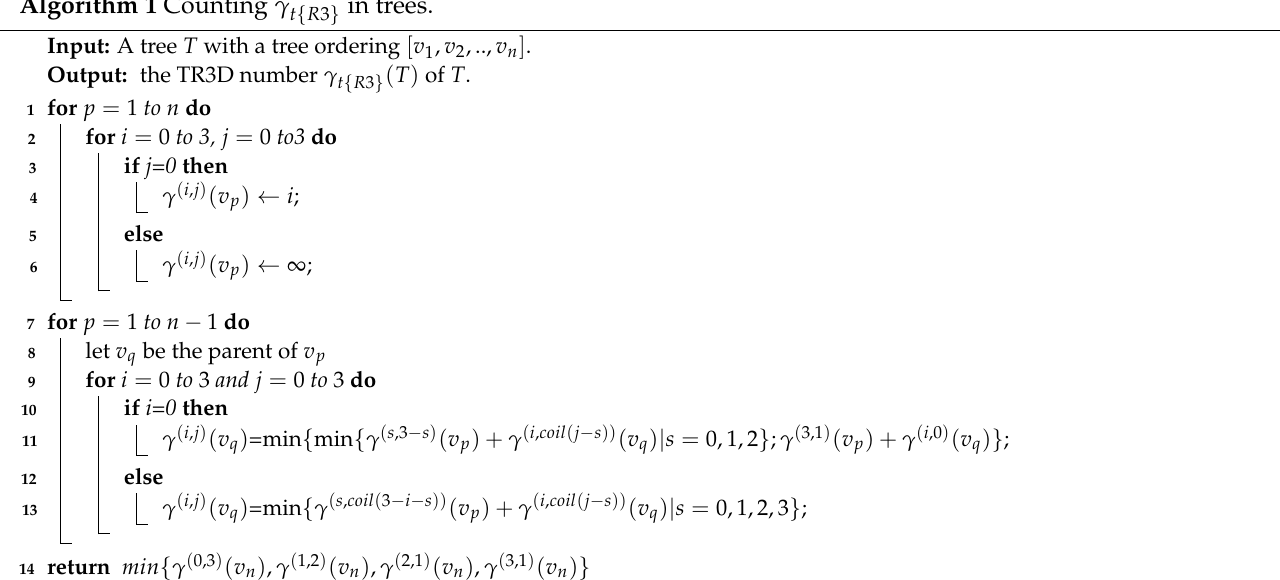
Algorithm 1 Counting γ